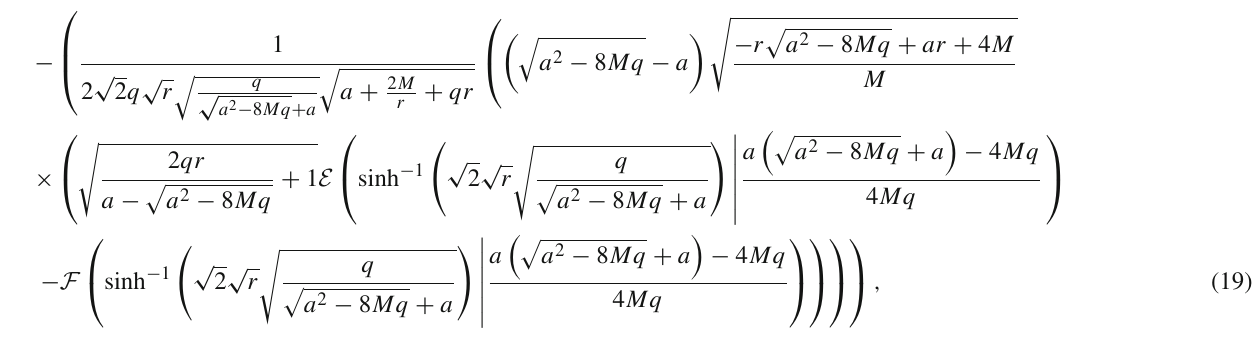
Fig. 3 Showsthebehaviorof t forthedifferentpossiblevaluesof a and q . The left panel of the first row represents q = 0 . 05 (blue), q = 0 . 06 (black), and q = 0 . 07 (red) with a = 0 . 7. The middle panel of the first row represents q = 0 . 05 (blue), q = 0 . 06 (black), and q = 0 . 07 (red) with a = 0 . 8. The right panel of the first row represents q = 0 . 05 (blue), q = 0 . 06 (black), and q = 0 . 07 (red) with a = 0 . 9. The left